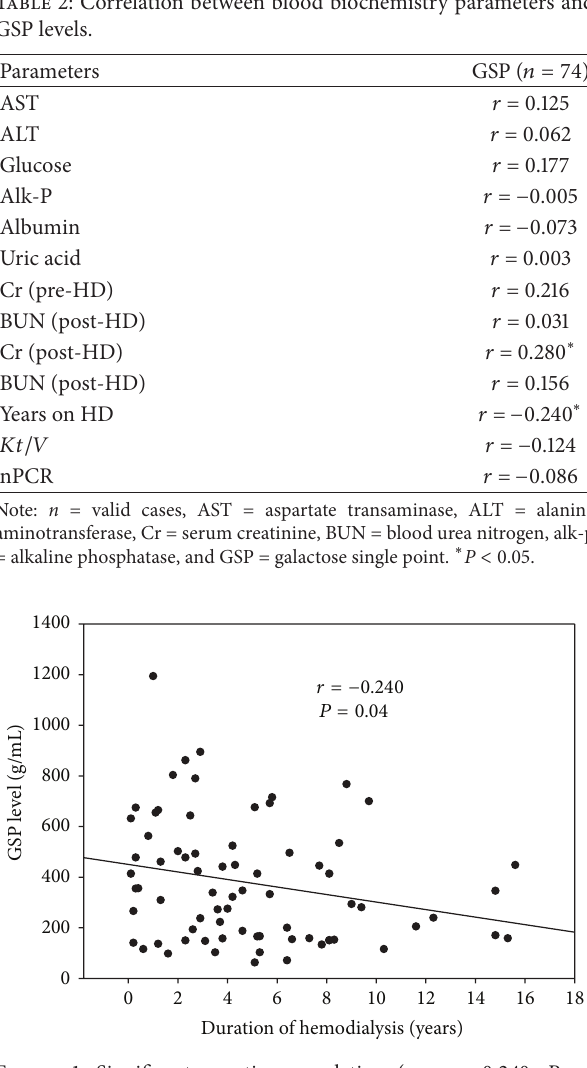
Figure 1: Significant negative correlation ( 𝑟 = −0.240 , 𝑃 = 0.04 ) between duration of hemodialysis of all patients and levels of galactose single